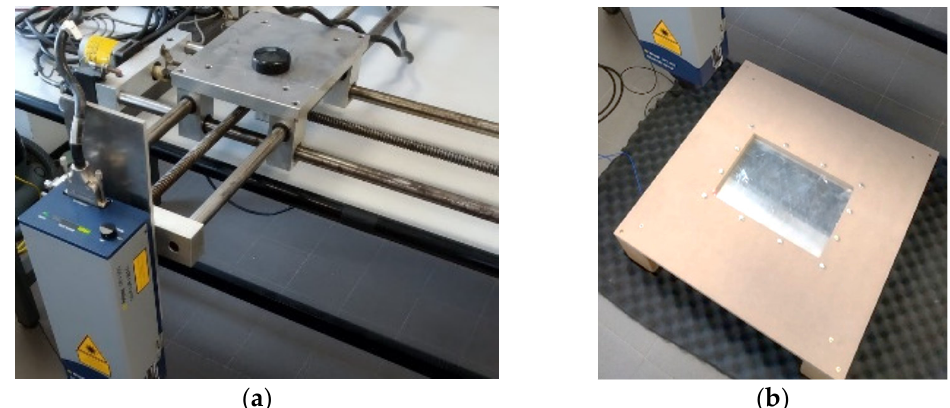
Figure 1. ( a ) Two-axis handling system of laser sensor head and ( b ) fully clamped aluminum plate mounted on a rigid baffle.